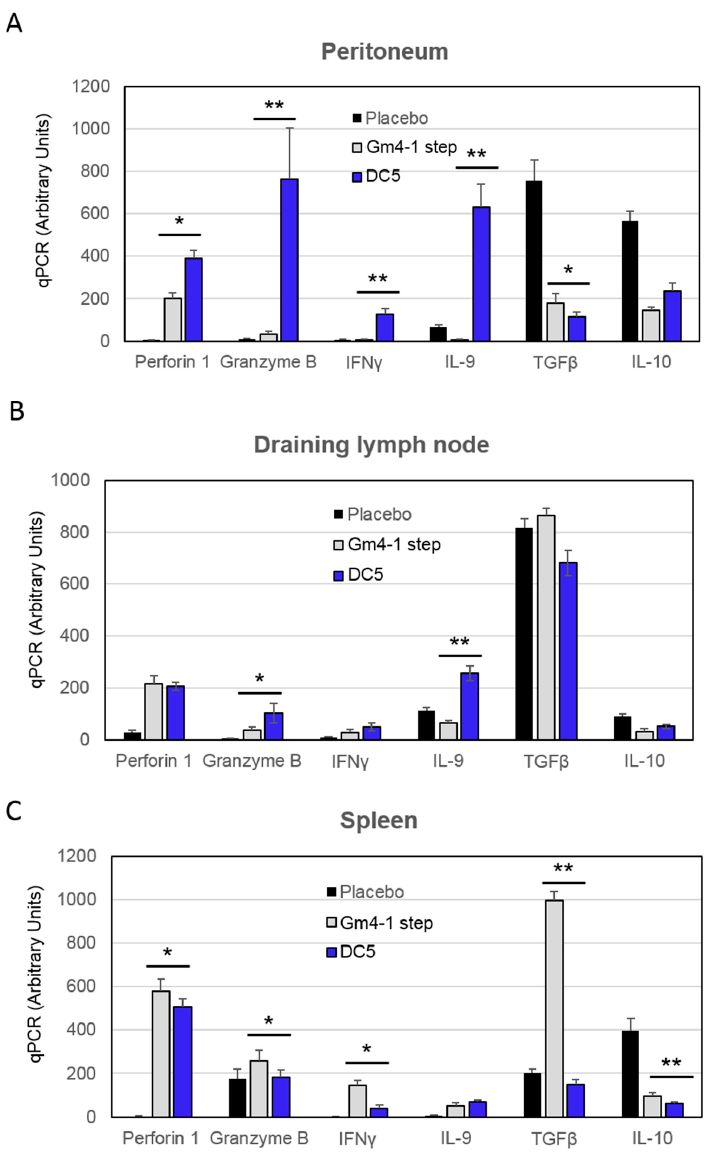
Figure 8. T cells isolated from DC5-vaccinated animals and stimulated ex-vivo with IL-12 present a more activated and cytotoxic mRNA profile. ( A – C ) T cells isolated from animals vaccinated as reported in Figure 6 were cultured for 24 h in the presence of IL-12. mRNA levels of indicated markers were then analyzed by qPCR. Data are representative of at least 3 independent experiments. Significant differences were assessed with unpaired Student’s t test and indicated with asterisks: * p < 0.05; ** p < 0.01. (IL-12: interleukin-12).